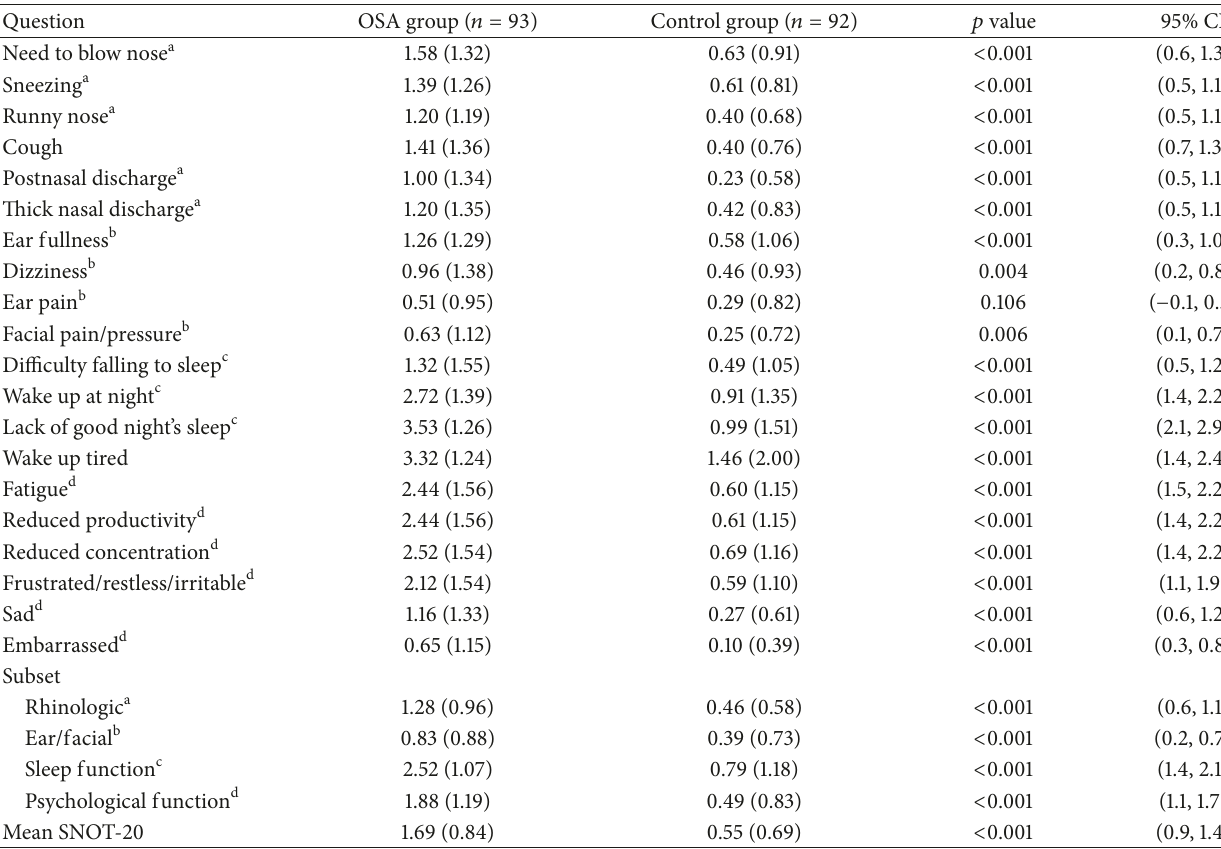
Table 2: Scores for the Sinonasal Outcome Test (SNOT-20) in the OSA group and controls. Data presented as mean (SD) and 95%